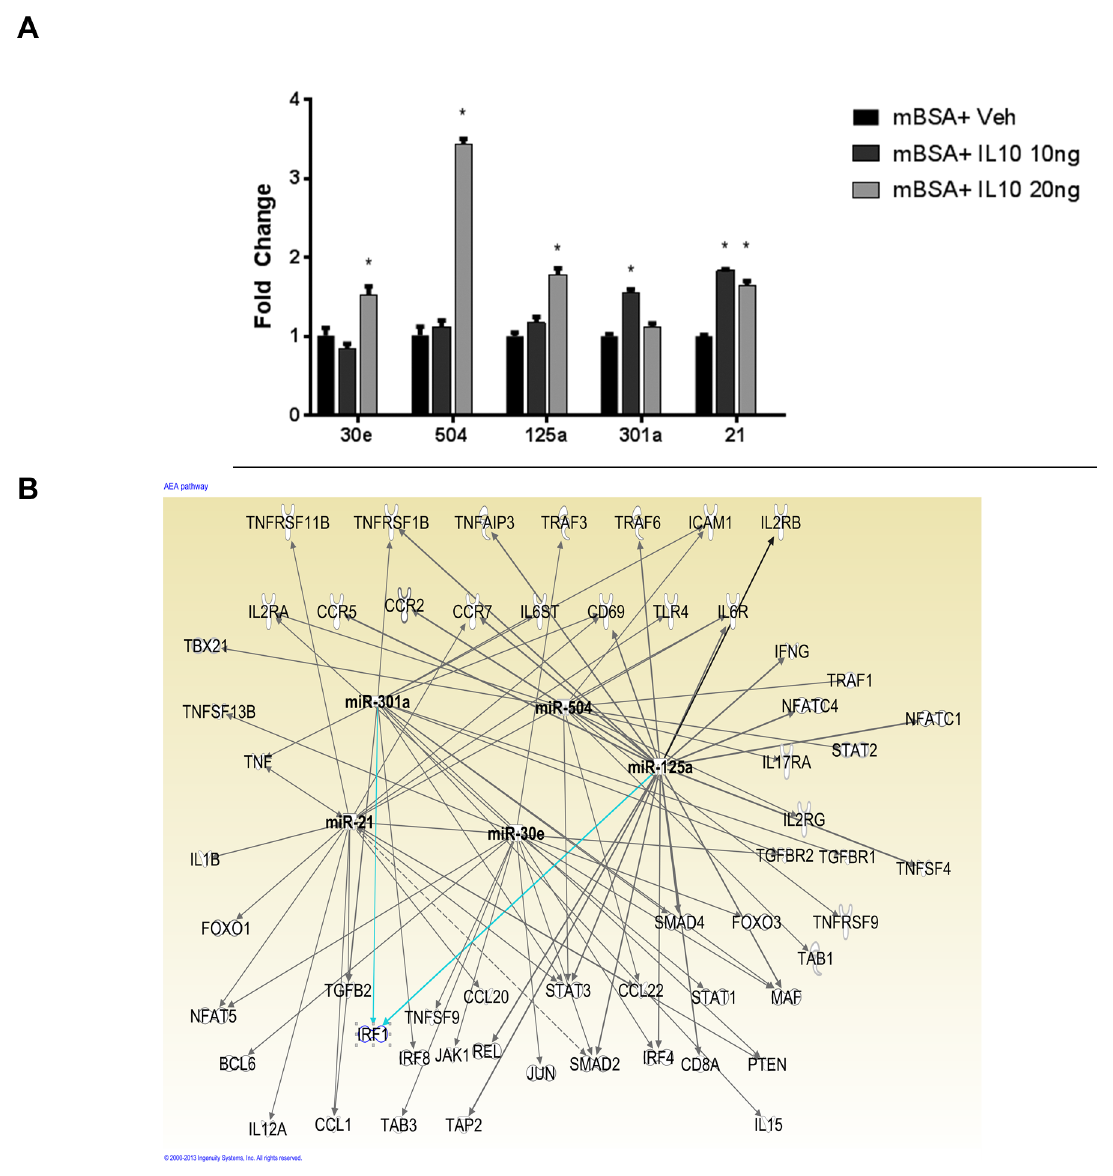
Figure 6. IL-10 induces miRNA that affect proinflammatory mediators. [A] RNA was isolated from mBSA rechallenged LN cells treated with vehicle or IL-10 [20, 10 ng/ml], as described in Fig 4. qPCR was performed to analyze changes in miRNA 21, 504, 125a, 30e, and 301a. Data are representative of 3 individual experiments with n=3. [B] Ingenuity pathway analysis [IPA] of miRNA targets for miRNA induced by IL-10. * p , 0.05 compared to